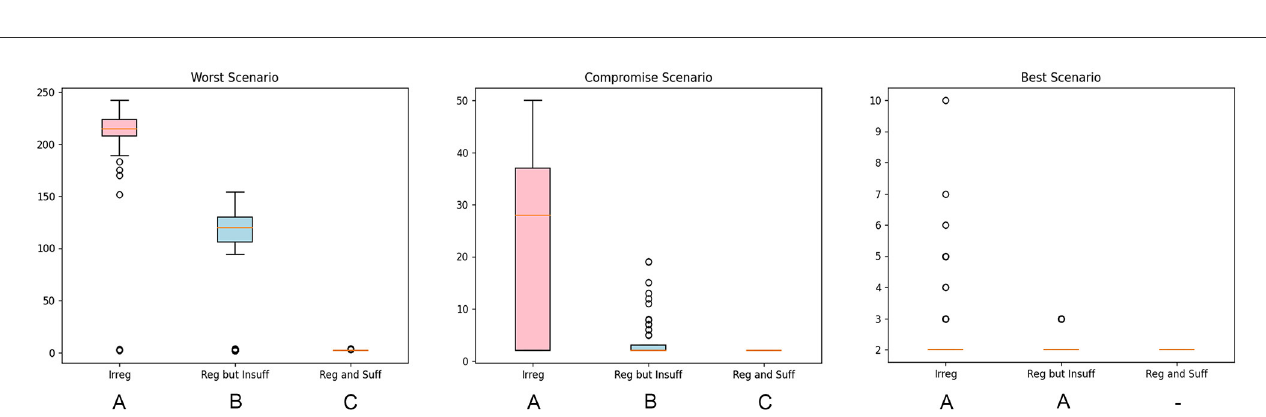
FIGURE5 Box plot of the simulated COVID-19 maximum number of cases for each food relief system with 100 replications for all of the scenarios. For the worst case, the Kruskal–Wallis H -statistic result: H = 252.914; p -value = 1.203 x 10 − 55 . Box plots not sharing the same letter are significantly different (Bonferroni-corrected p < 0.05). For the compromise cases, the Kruskal–Wallis test H -statistic result: H = 110.858; p -value = 8.461 x 10 − 25 . Box plots not sharing the same letter are significantly different (Bonferroni-corrected p < 0.05). Finally, for the best case, the Mann–Whitney U -test result: U = 5355.0, p -value = 0.1506. Box plots sharing the same letter are not significantly different ( p < 0.05). Box plot with no letter indicates no variability, hence statistical inference for multiple group comparison was not